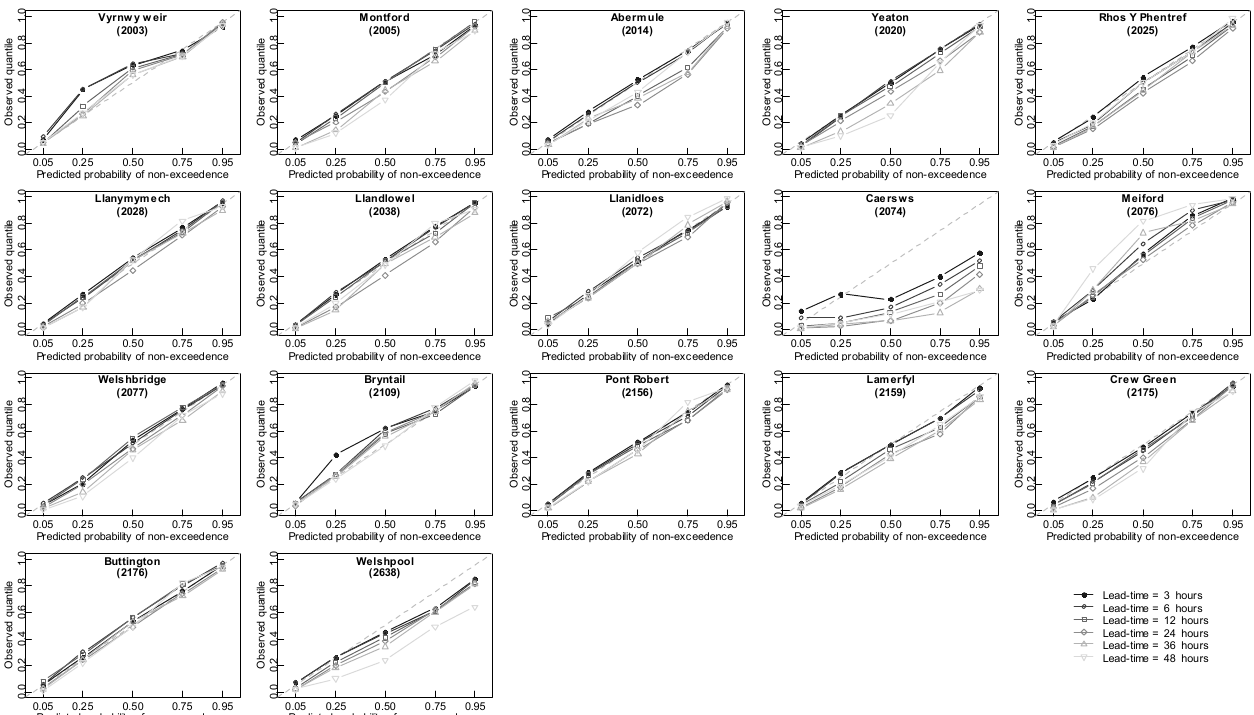
Figure 7. Reliability Q-Q plots (predicted non-exceedence probabilities versus the fraction of observations that are lower than the corresponding estimated value indicated by “observed quantiles”) for all Upper Severn locations for all lead times considered for the validation period (2008 and 2009). Bracketed numbers are unique station identifiers.